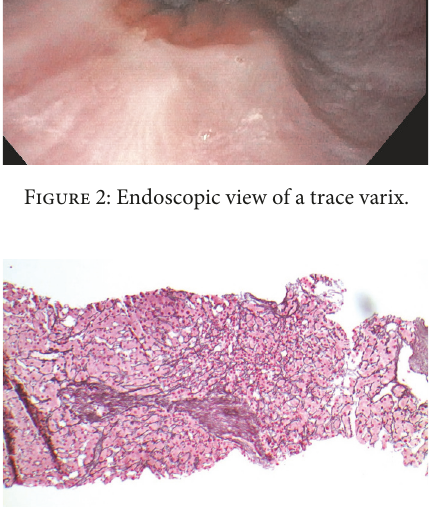
Figure 3: (Reticulin, 100x) hepatic parenchyma exhibiting subtle nodularity without significant